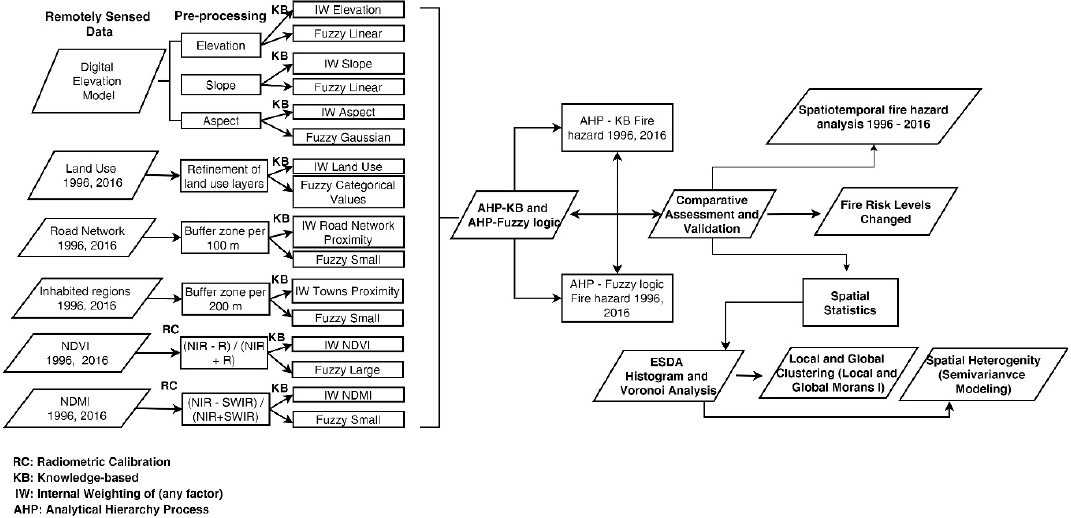
Figure 2. Flowchart of the spatiotemporal analysis and variability of fire hazard 2.3.1 Classification of Critical Factors—Analytical Hierarchy Process (AHP) for knowledge-based and fuzzy logic models for remote sensing data fusion.